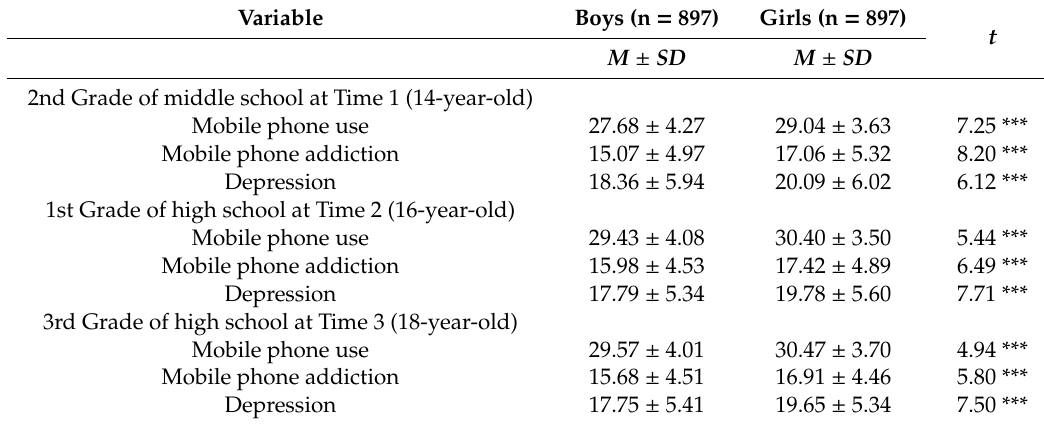
Table 2. Group mean comparisons of major variables between boys and girls ( N =